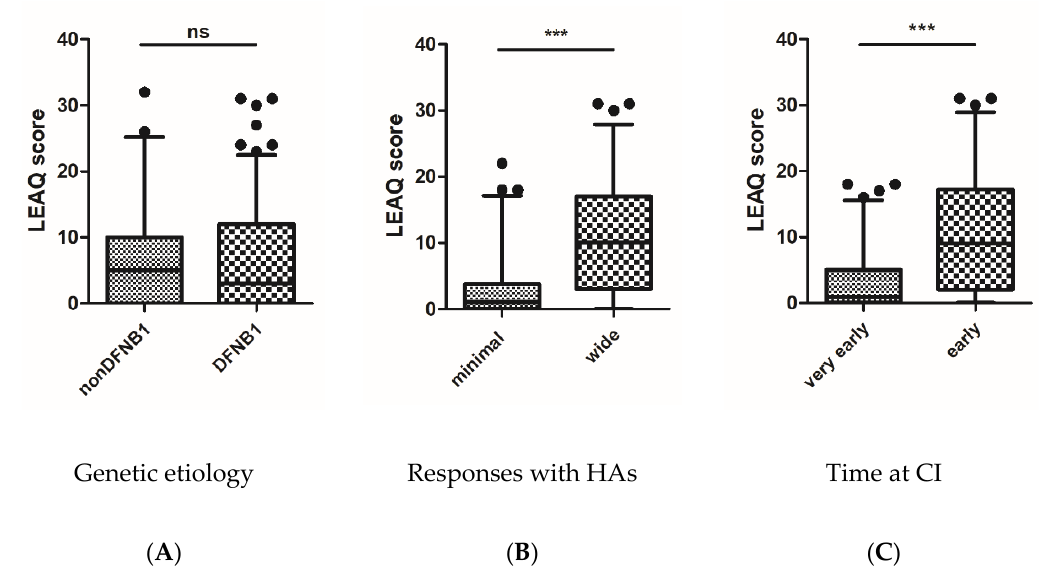
Figure 1. LEAQ scores at the time of cochlear implant activation. ( A ) Differences in LEAQ scores in patients with and without DFNB1 locus pathogenic variants; ( B ) differences in LEAQ scores in patients with minimal and wide responses provided by HAs; ( C ) differences in LEAQ scores in patients with very early and early CI. Whiskers represent 5–95 percentile, and black dots indicate outliers. Asterisks represent statistical significance, *** p < 0.001; ns, not significant.